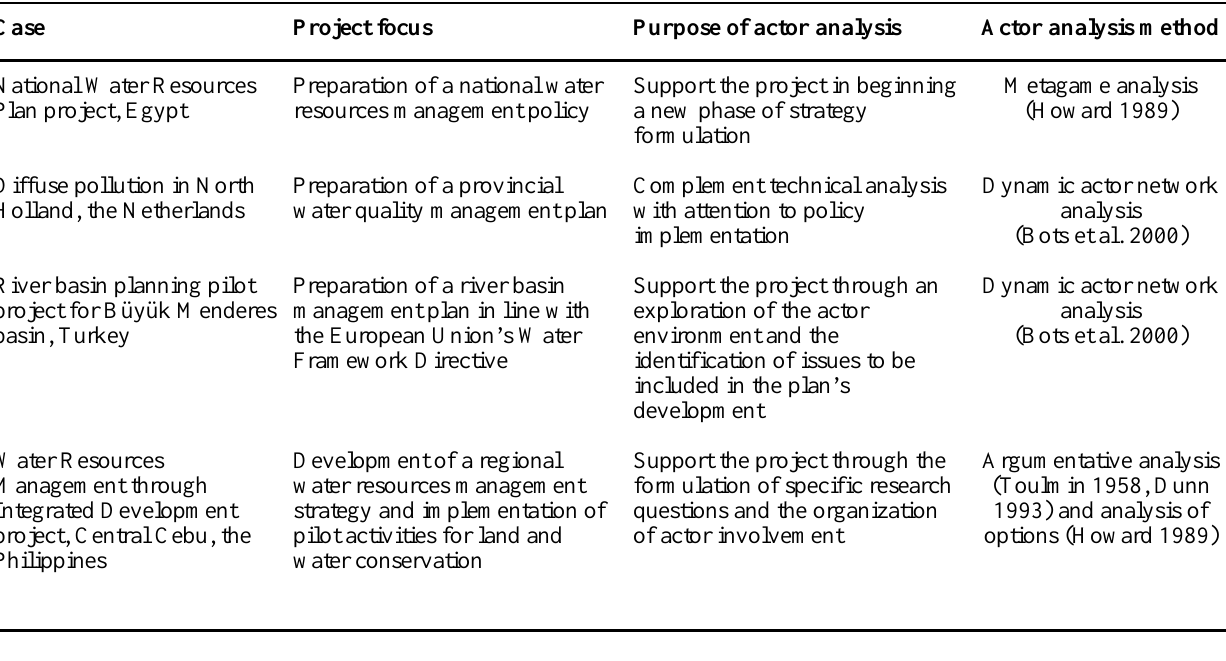
Table 1. Overview of the case